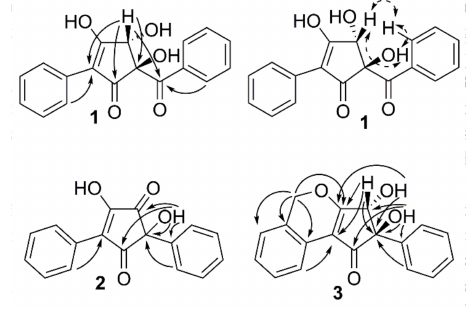
Figure 2. Key HMBC (solid arrows) and ROESY (dashed arrows) correlations for structure determination of compounds 1 – 3